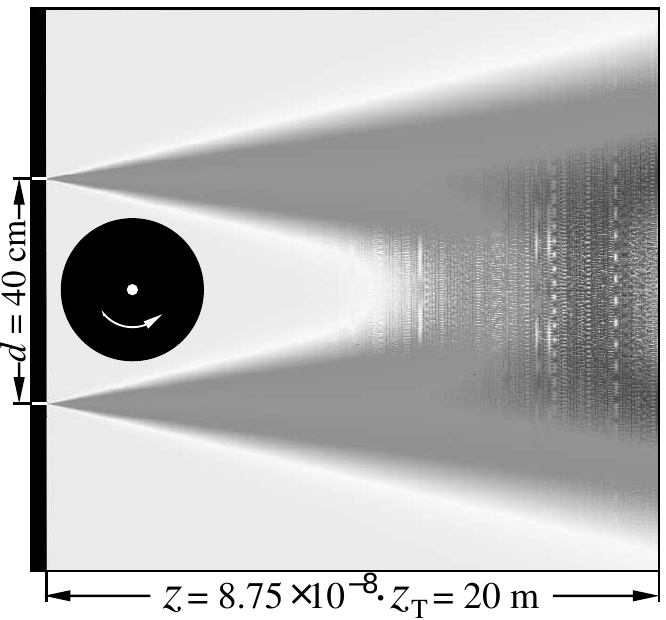
Figure 18. The density distribution p ( z , x ) = (cid:104) ψ ( z , x ) | ψ ( z , x ) (cid:105) calculated from the wave function (133) with omitting the amplitude factor. The rotating disks are placed in the shadow